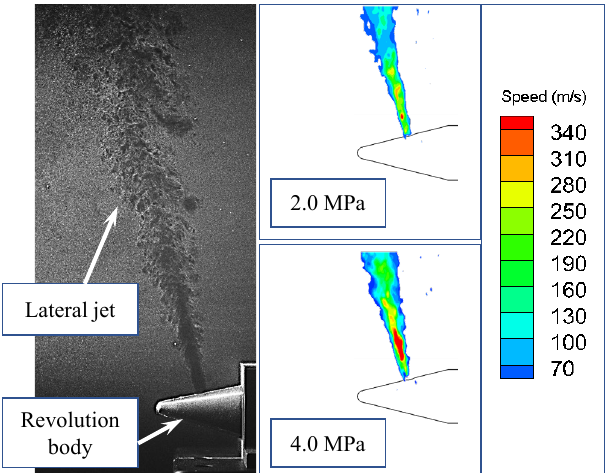
Figure 5. Nozzle velocity measurement.